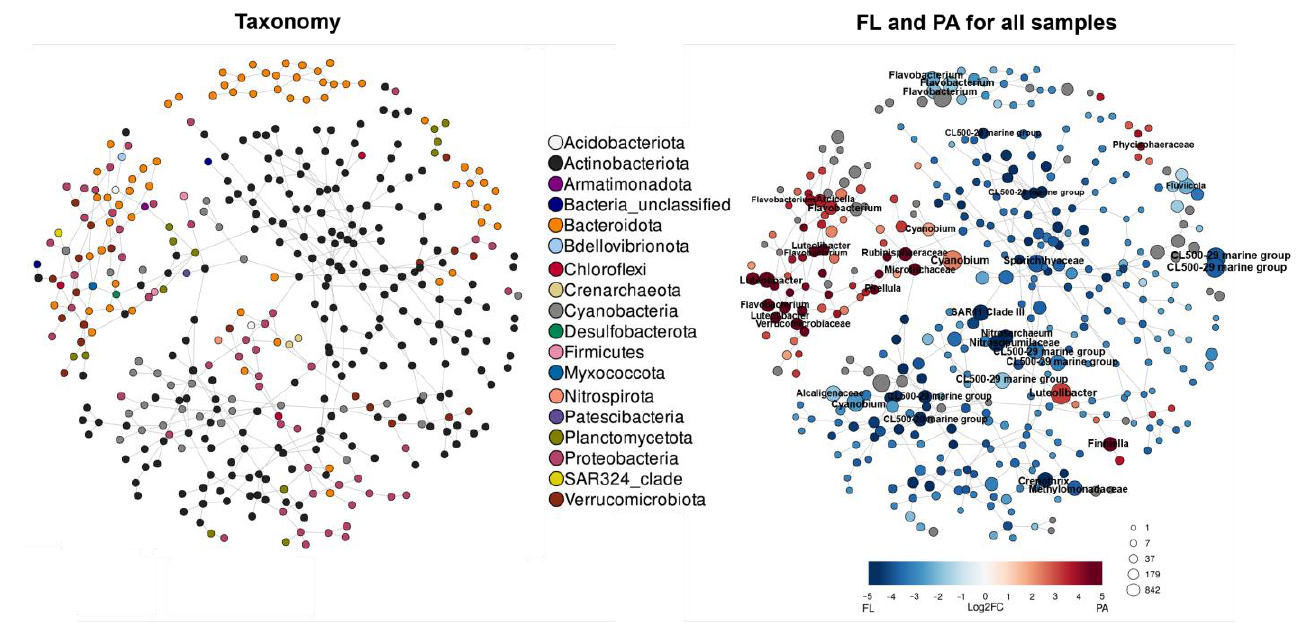
Figure 10. Co-occurrence networks of FL and PA communities. Graph layout colored by taxonomic assignment of OTUs (vertices) at the phylum level (in the left panel ), and overall lifestyle differential abundance (DA) Log2FC (in the right panel ). The size of vertex in DA-graphs is proportional to mean OTU abundance.